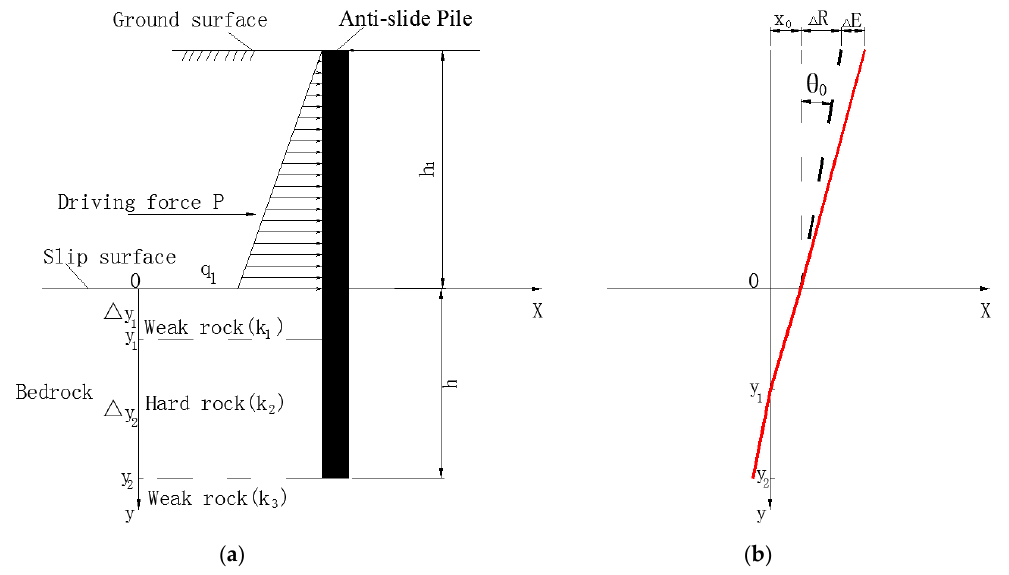
Figure 5. Stress and deformation model of the anti-slide pile under a triangular load in two strata with different strengths — ( a ) a sketch of lateral triangular load acting on the pile; ( b ) a composition of anti-slide pile deformation.